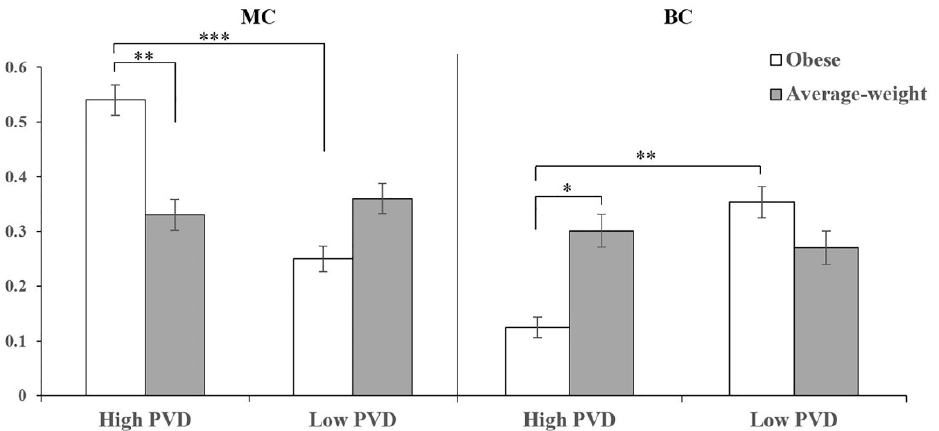
Figure 5. The influences of the interaction between PVD and disease-connoting cue on MC fluency and BC fluency (displayed ± SE ). * p < 0.05; ** p < 0.01; *** p < 0.001.